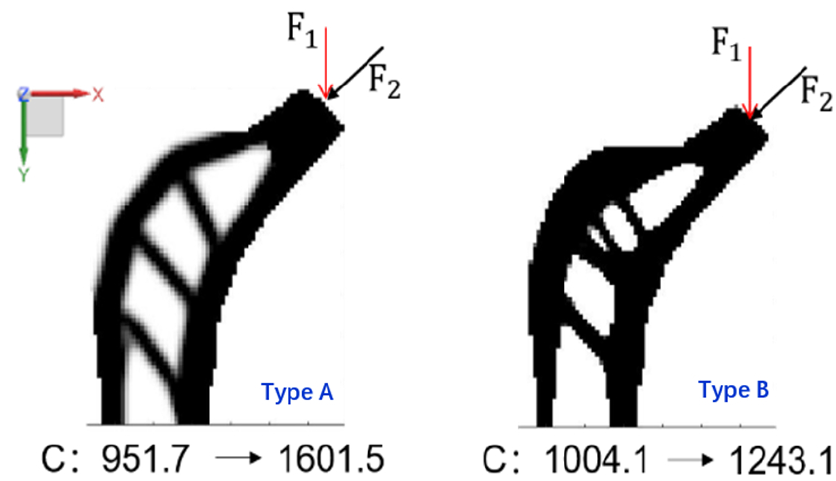
Figure 5. Variation of structural compliance when load force direction changes.